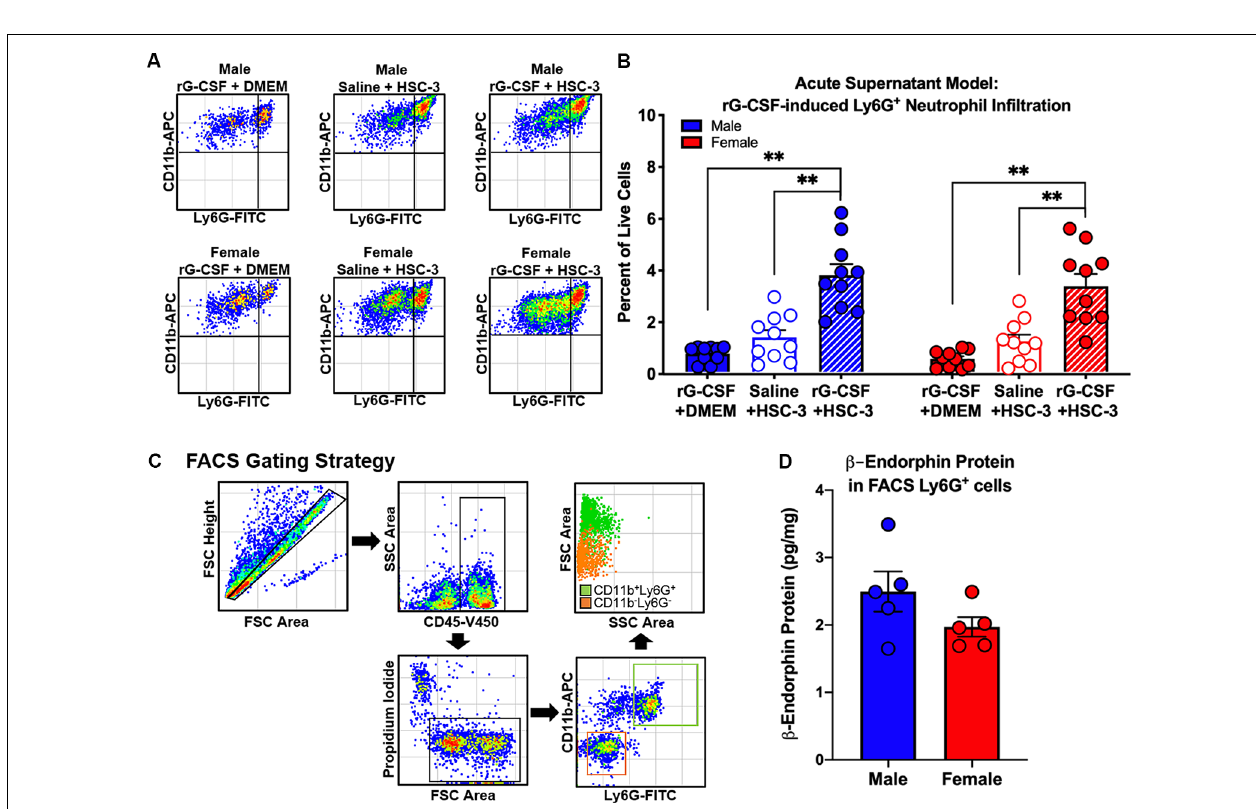
FIGURE 2 | Oral cancer supernatant-induced immune infiltration was measured using the acute supernatant model. (A) Representative scatter plots showing CD11b + Ly6G + neutrophils from the tongues of an adult C57Bl/6 male (top) and female (bottom) mouse 48 h after either rG-CSF treatment followed by cell culture media (rG-CSF+DMEM, solid bar), saline followed by HSC-3 cell culture supernatant (Saline+HSC-3, open bar), or rG-CSF treatment followed by HSC-3 cell culture supernatant (rG-CSF+HSC-3, striped bar). (B) Average Ly6G + neutrophil quantification in the tongues of male ( N = 10/group, blue bars) and female ( N = 10/group, red bars) mice after treatment. One-way analysis of variance (ANOVA), ∗∗ P < 0.01. (C) Representative gating strategy used to isolate cancer-activated tongue immune cells by fluorescence-activated cell sorting (FACS). (D) Quantification of mean β -endorphin protein in CD11b + Ly6G + immune cell subpopulations from HSC-3 supernatant-treated male (blue, N = 5) and female mice (red, N = 5) relative to total protein. Sorted cells were pooled from two mice for each sample. Unpaired Student’s t -test, P > 0.05.